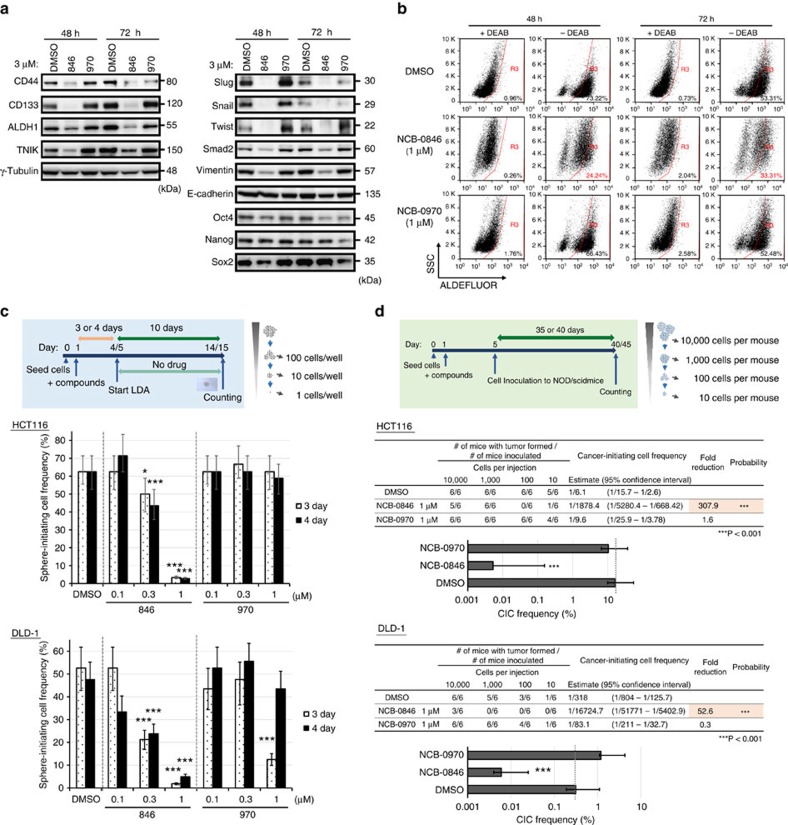
TNIK inhibition abrogates colorectal cancer stemness.(a) HCT116 cells were treated with DMSO (vehicle), NCB-0846 (3 μM), or NCB-0970 (3 μM) for 48 or 72 h. The expression of the indicated proteins was analyzed by immunoblotting. (b) HCT116 cells were treated with DMSO (vehicle), NCB-0846 (1 μM) or NCB-0970 (1 μM) for 48 or 72 h. The population of cells with ALDEFLUOR intake in the presence (negative control) and absence of N,N- DEAB was determined by flow cytometry. Gates were set according to the highest intake of ALDEFLUOR by cells in the DEAB control. Abbreviation: SSC, side scatter. (c) Reduction in the frequency of sphere-forming cells by NCB-0846. HCT116 and DLD-1 cells were treated with DMSO, or with the indicated concentration of NCB-0846 or NCB-0970, for 3 or 4 days. Viable cells were distributed into 96-well U-bottomed culture clusters at a density of 1, 10 or 100 cells per well and cultured for 10 days. The frequency of sphere-forming cells was computed using ELDA software (***P<0.001 relative to DMSO). (d) Reduction of colorectal cancer cell tumour formation by NCB-0846. HCT116 and DLD-1 cells were treated with DMSO (control), NCB-0846 (1 μM) or NCB-0970 (1 μM) for 96 h. Viable cells were injected into the subcutaneous tissues of 6-week-old male NOD/ShiJic-scid mice at a density of 10, 100, 1,000 or 1 × 104 cells per mouse. Thirty-five (HCT116) and 40 (DLD-1) days later, the number of mice that had developed tumours was counted. The frequency of tumour-forming cells was calculated using ELDA software (***P<0.001 relative to DMSO). CIC, cancer-initiating cell.